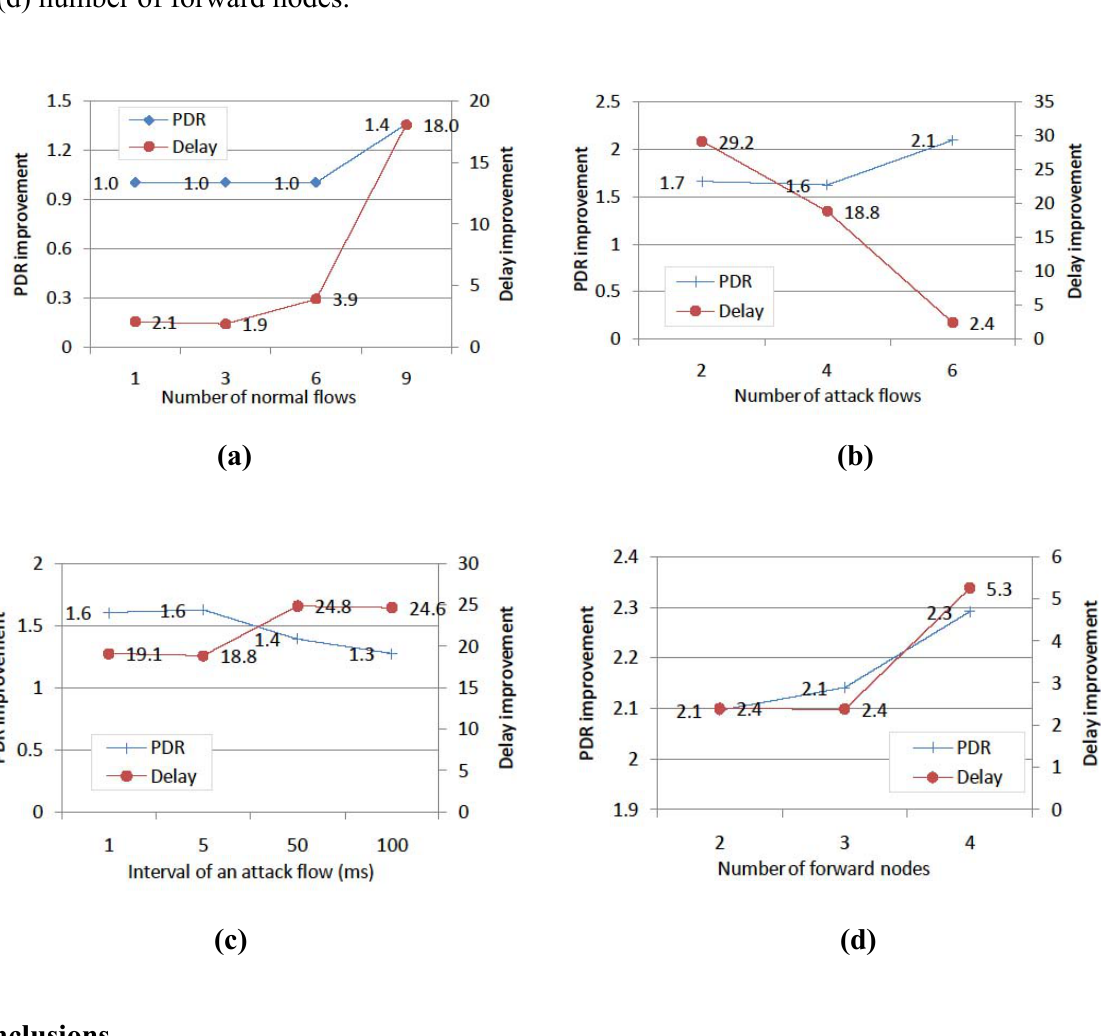
Figure 9. The performance improvement of DMP compared to JAM, according to (a) number of normal flows, (b) number of attack flows, (c) interval of an attack flow and (d) number of forward